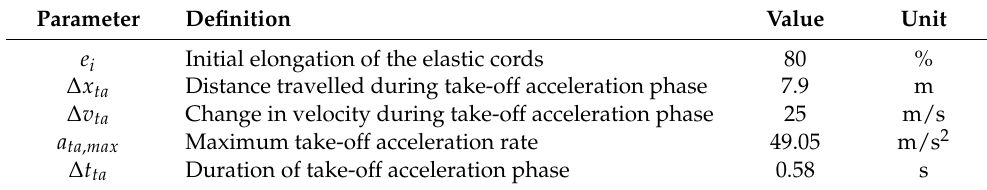
Figure 11. The carriage dynamics at take-off during the acceleration phase ( a ) and deceleration phase ( b ). Table 10. The dynamics of the carriage during the take-off acceleration phase.